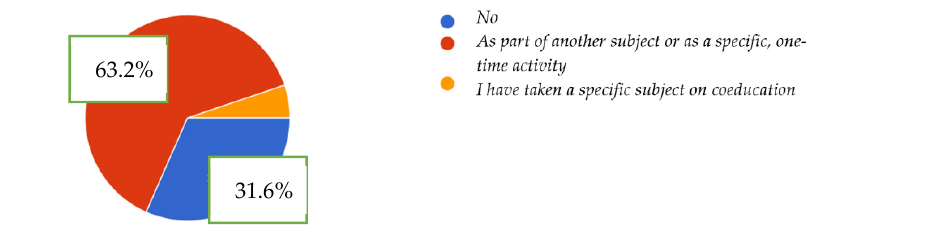
Figure 2. Contingency graph. Qualifications. Table 4. Descriptive statistics of central tendency for question 2.